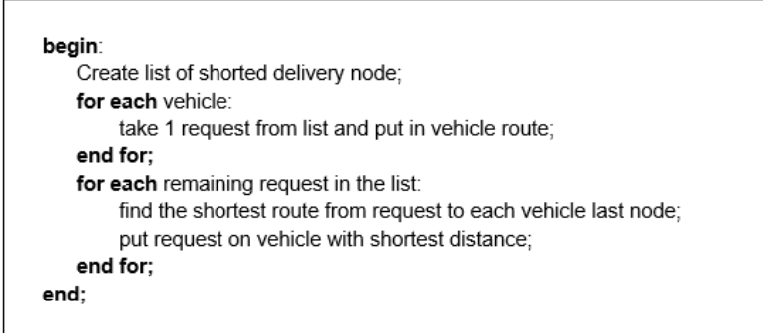
Figure 2. A pseudocode of the initial solution.